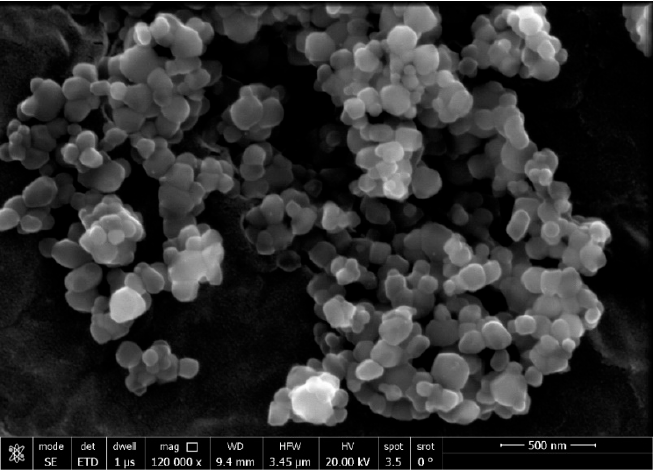
Figure 4. Electron micrographs of the green synthesized AgNPs capped with ELLE. ( A ) TEM and ( B ) SAED.